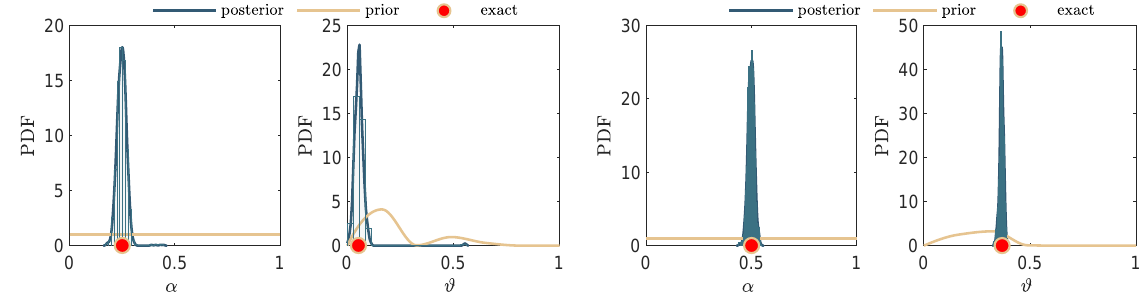
Figure 5. Identified damage severity ˆ α , and damage location ˆ ϑ , using the frequency-based algorithm for ( noise = 1% ) : ϑ = 0.05, and α = 25% ( left ); ϑ = 0.37, and α = 50% ( right ).